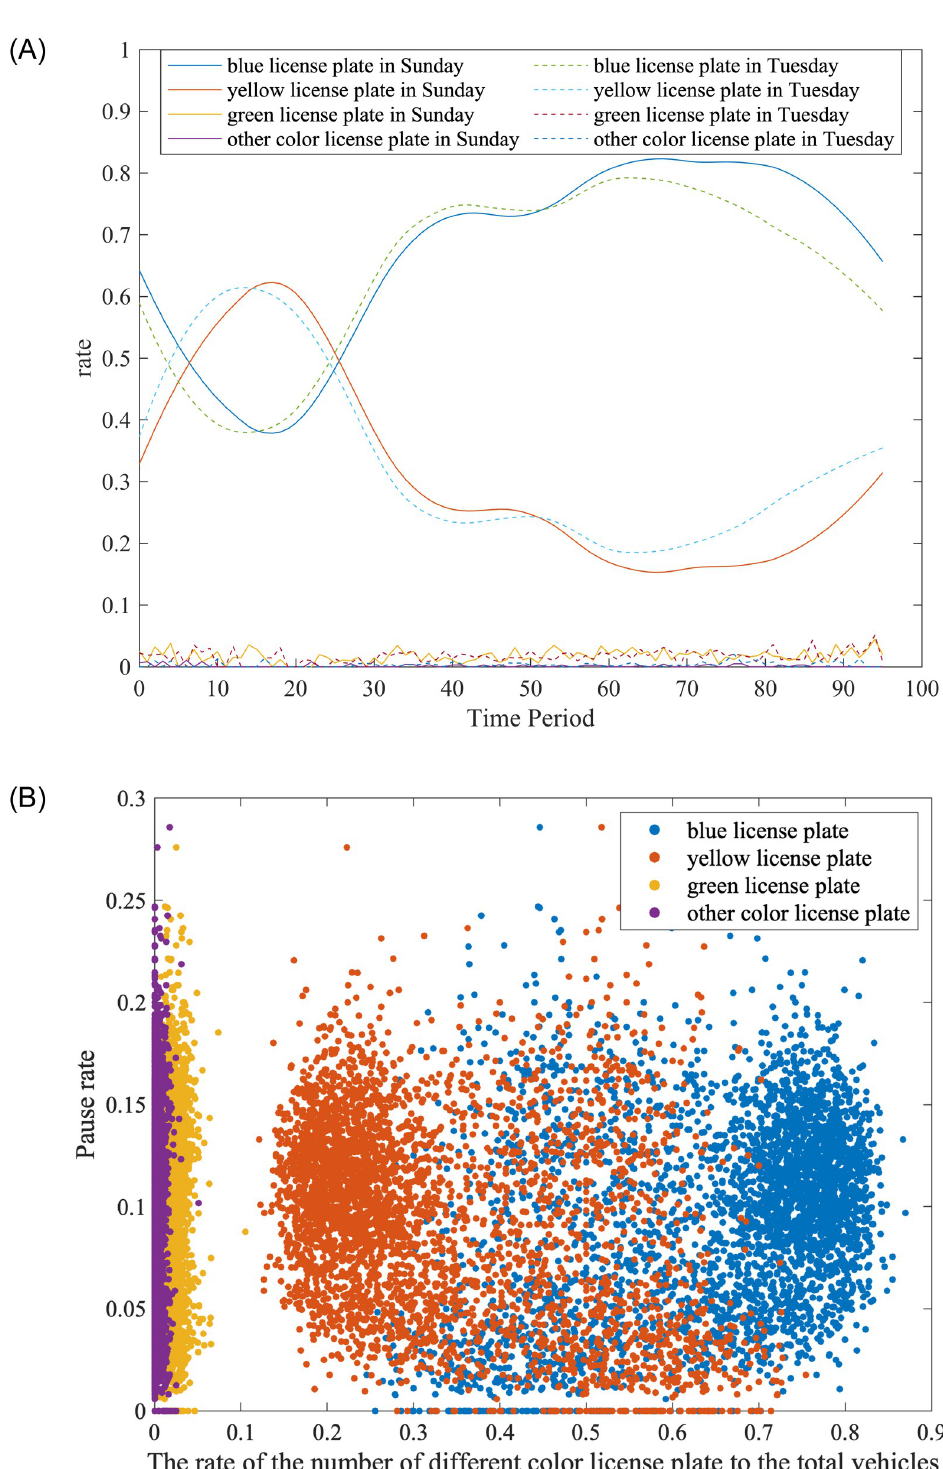
Fig 6. Correlation of traffic composition with time and pause rate. A: Time dependence of traffic composition. B: Correlation of traffic composition with pause rate.